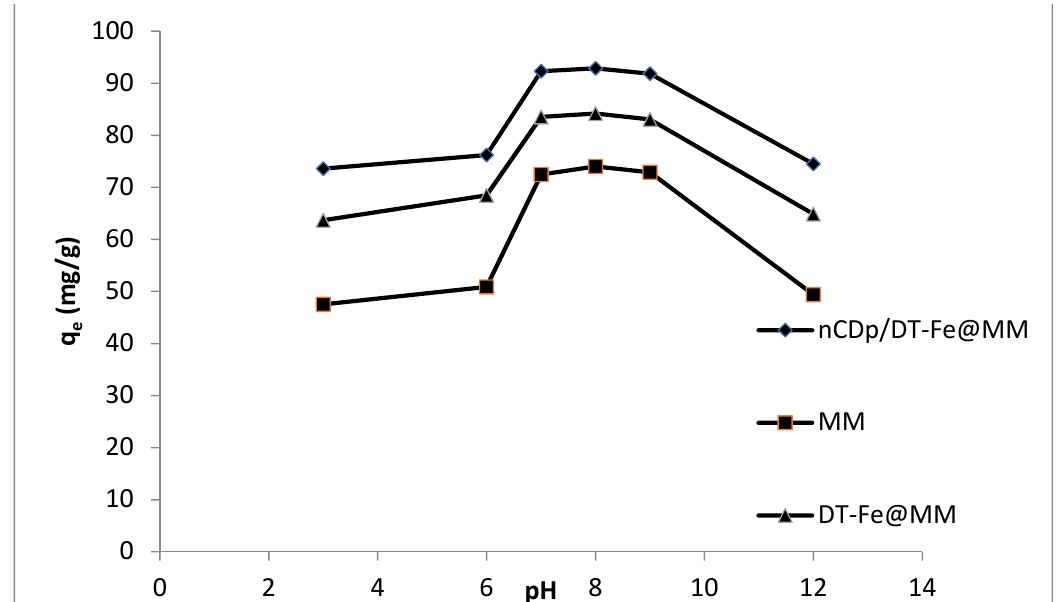
Figure 12. Effect of pH on the removal of BPA. (Adsorption conditions: C o 50 mg/L; T = 30 °C; dosage = 0.02 g/L; t = 120 min).